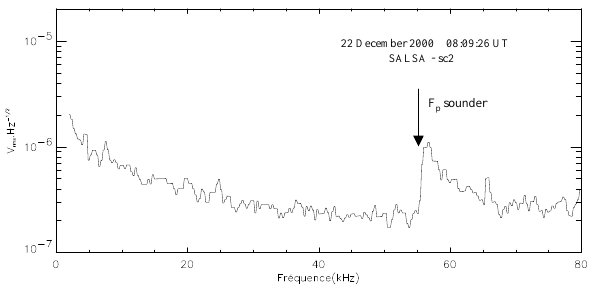
Fig. 2. A single spectrum (16 bin-to-bin accumulations) covering a 213 ms time interval, taken in the magnetosheath region. The emission above the plasma frequency (55.4 kHz) identified by the sounder, is thought to be electron thermal